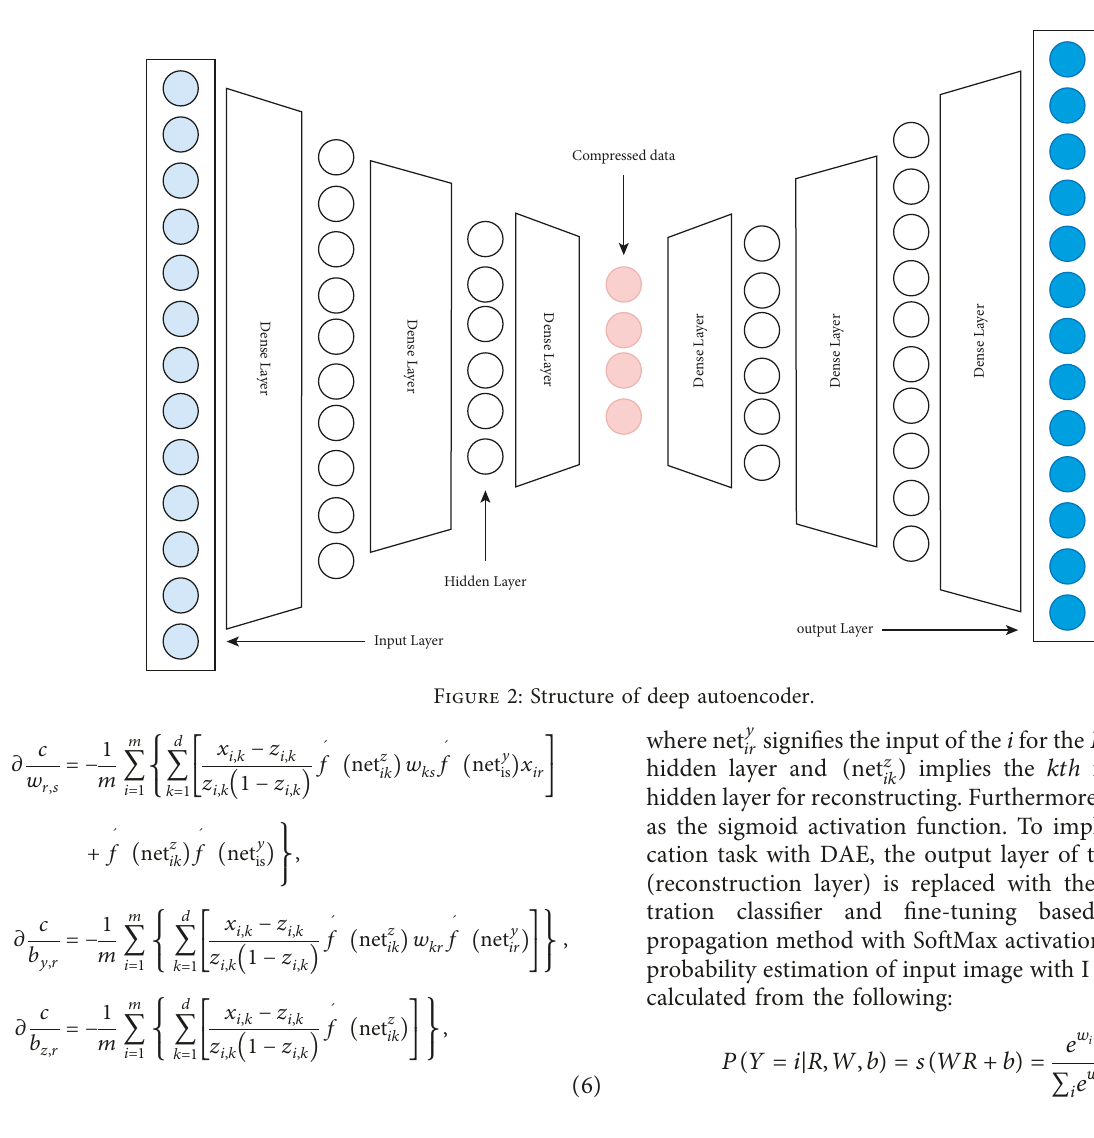
Figure 1: Directional bite-planes of a brain MRI image.